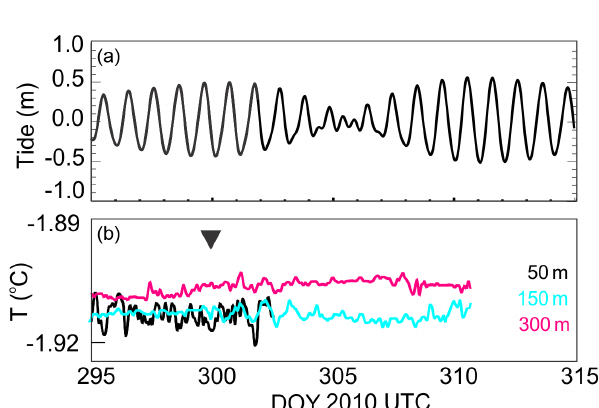
Figure 3. (a) Tidal elevation and (b) in situ temperatures from back- ground mooring (shown in Fig. 2). The time of the present detailed observations are marked with the triangle in (b) . The sensor at 50m stopped early due to battery exhaustion.